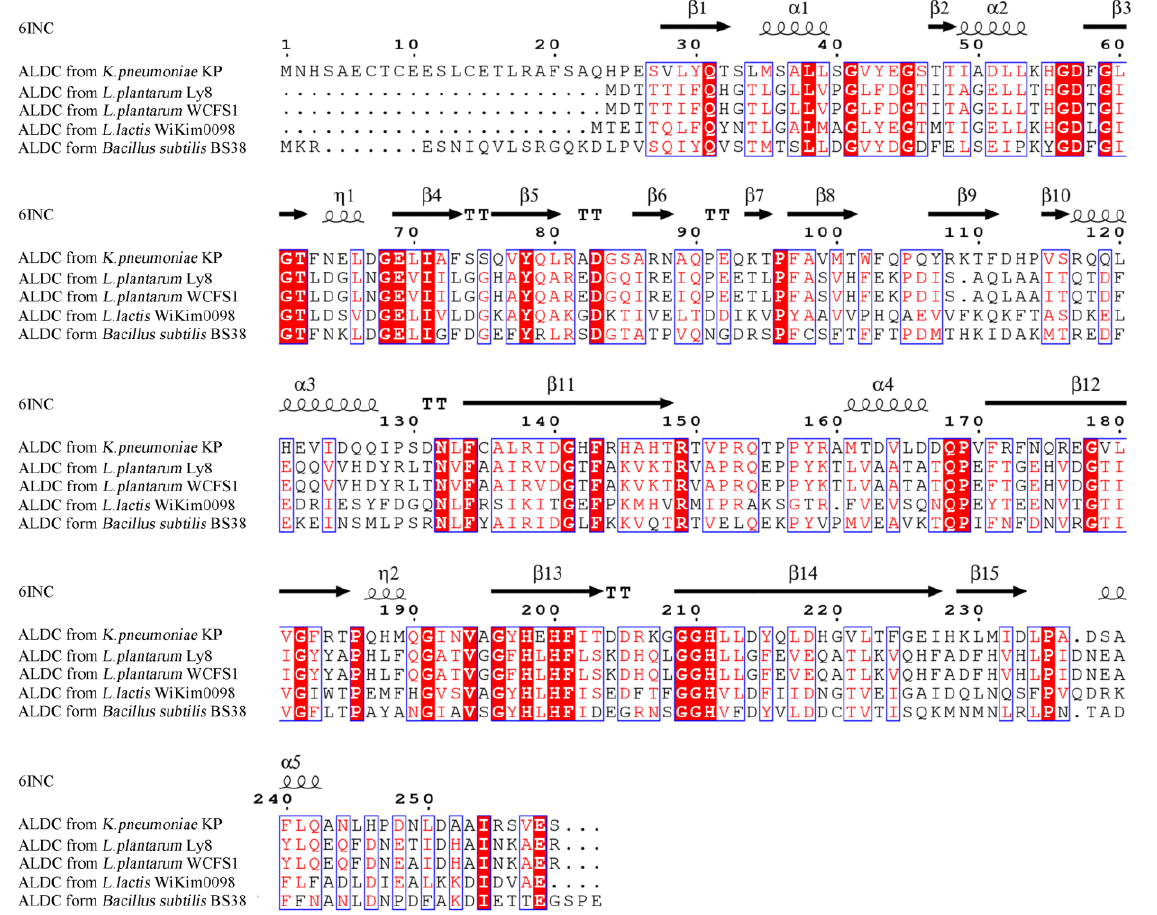
Figure 1. Sequence alignment of ALDC from K. pneumonia KP, L. plantarum Ly8, L. plantarum WCFS1, L. lactis WiKim0098 and Bacillus subtilis BS38. Residues conserved in all five proteins are highlighted with a red background. ALDC from K. pneumoniae secondary structure elements (6INC) are indicated at the top of each panel. α: α-helix; β: β-sheet; T: β-turns; η: 3/10-helix.